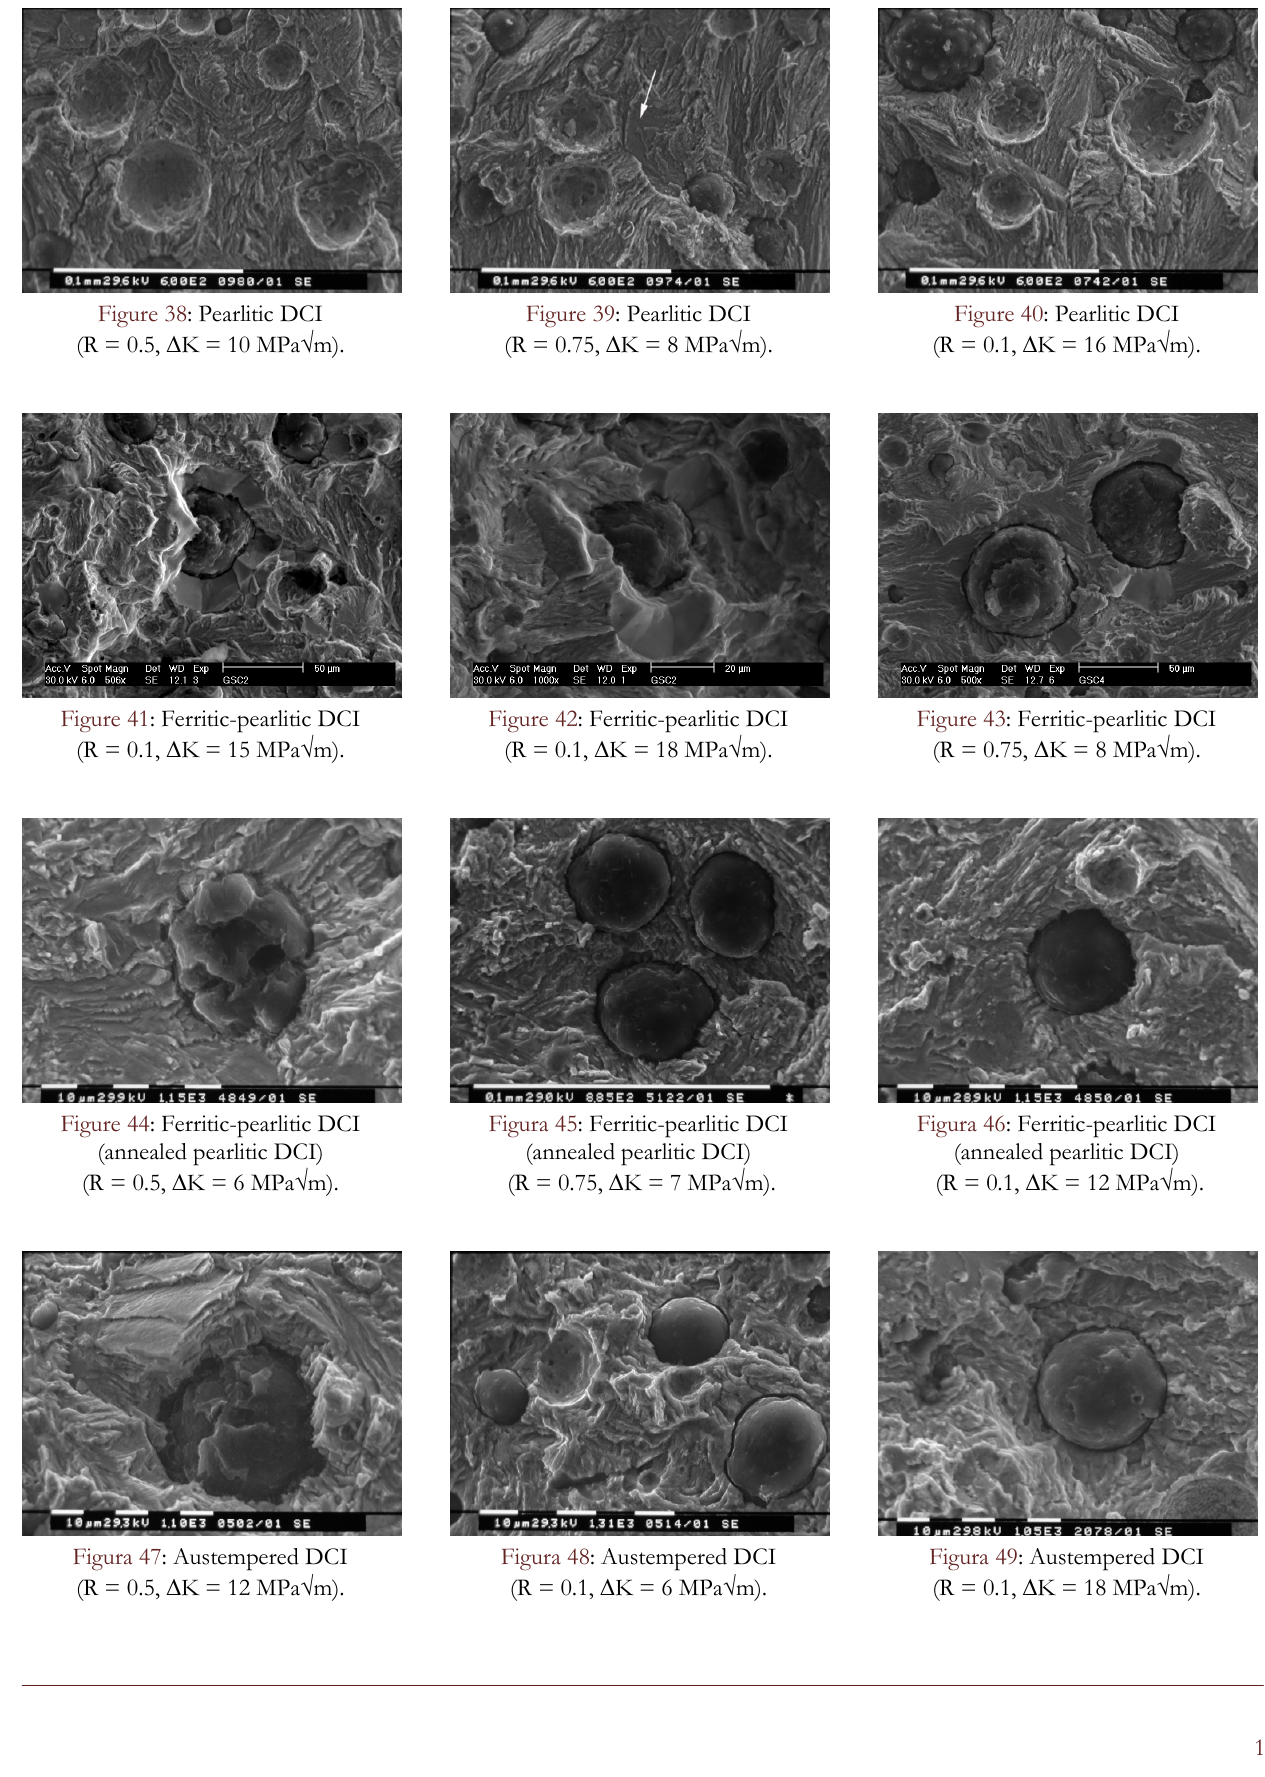
Figura 47: Austempered DCI (R = 0.5,  K = 12 MPa √ m).